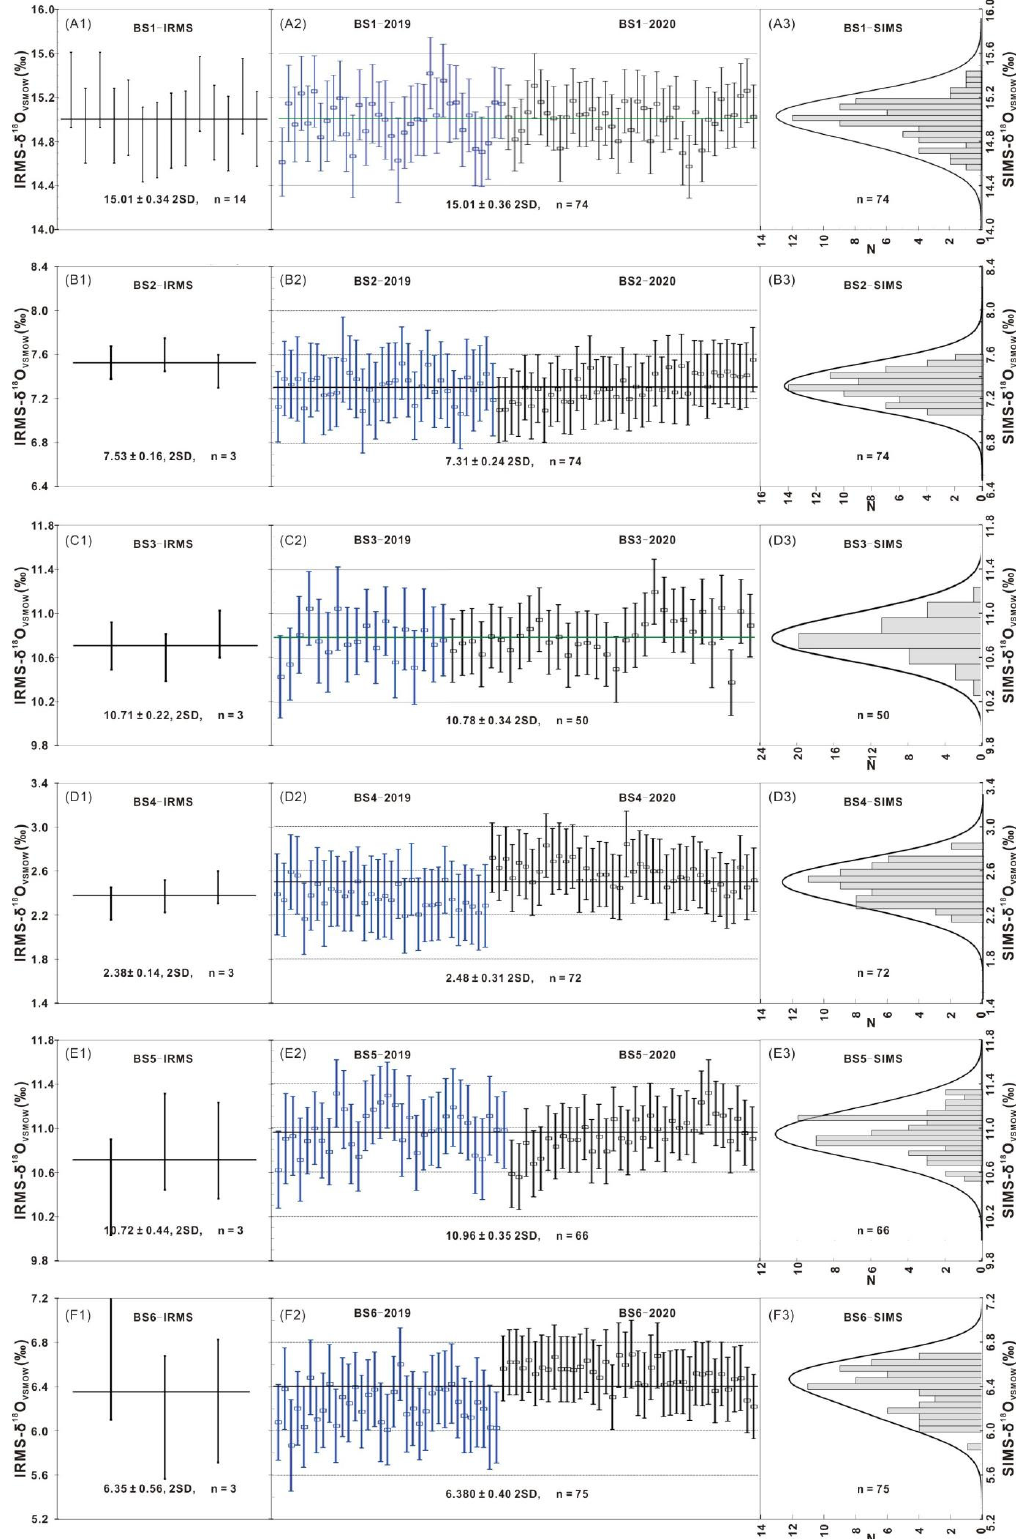
Figure 5. The laser fluorination isotope ratio mass spectrometry (IRMS) values of the six beryl samples and the SIMS δ 18 O (‰) values of these samples, which were normalized to the IRMS value of BS1: ( A1 – F1 ) are the IRMS δ 18 O mean values of BS1, BS2, BS3, BS4, BS5, and BS6, respectively; ( A2 – F2 ) are the SIMS δ 18 O mean values of BS1, BS2, BS3, BS4, BS5, and BS6, respectively; ( A3 – F3 ) are the frequency distributions of SIMS δ 18 O values of BS1, BS2, BS3, BS4, BS5, and BS6,